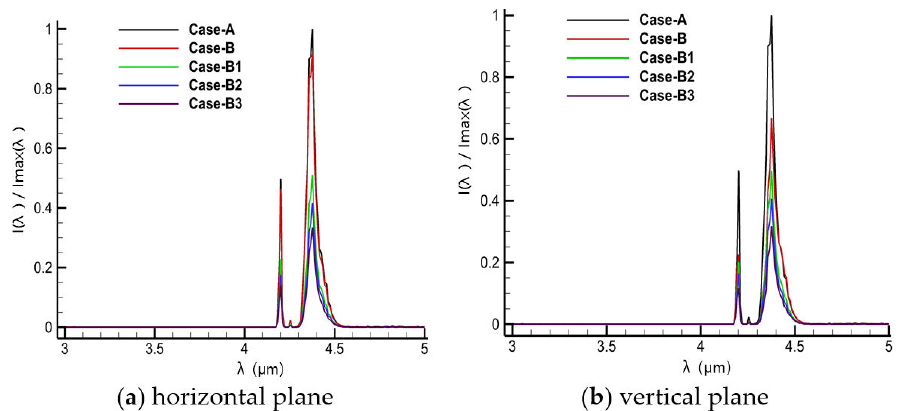
Figure 12. Dimensionless spectral radiant intensity of a hot jet at a detective angle a = 60 ◦